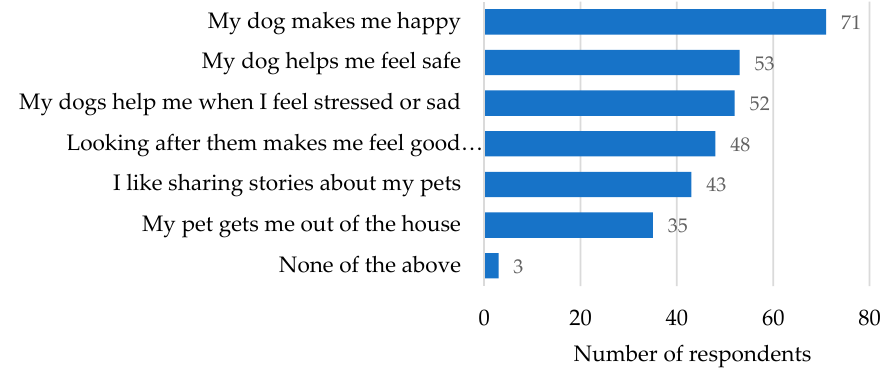
Figure 2. Positive aspects of dog ownership identified by dog owners in nine Aboriginal communities in New South Wales, Australia.